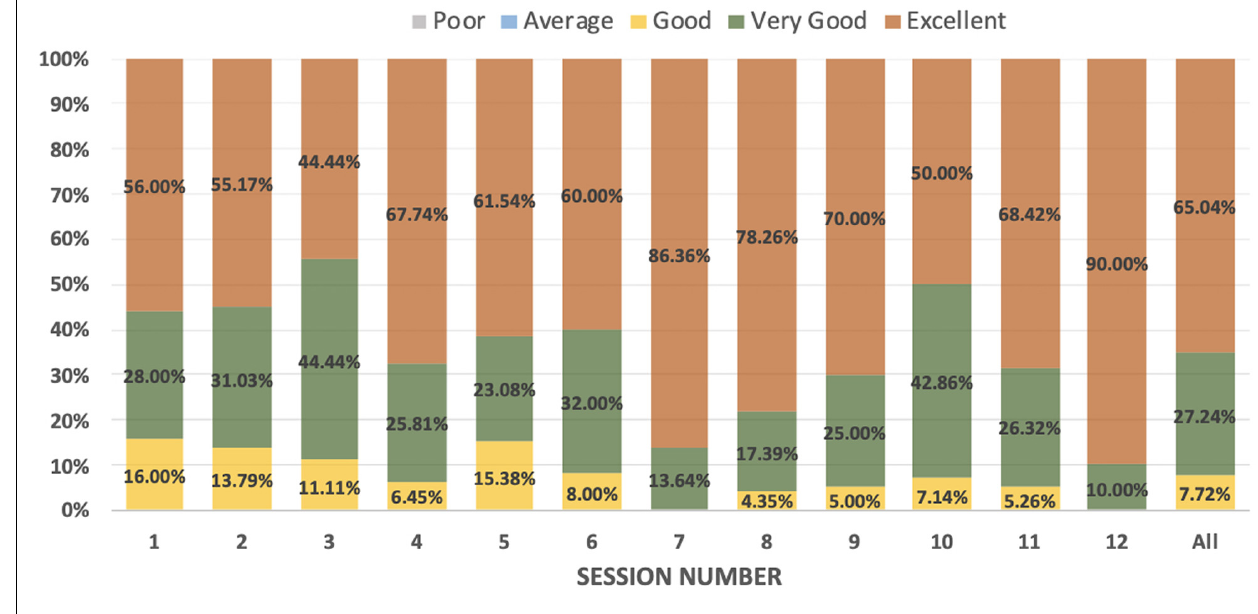
FIGURE 1 | Distribution of rating for online sessions.